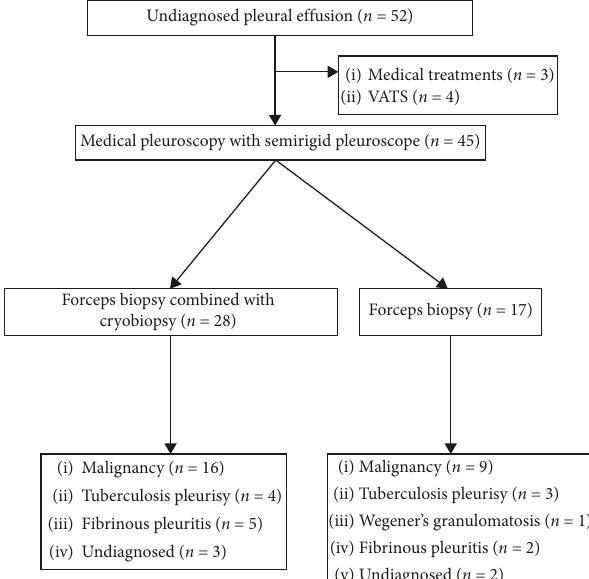
Figure 1: Diagnosis of patients who received pleuroscopic cryo- biopsy and flexible forceps